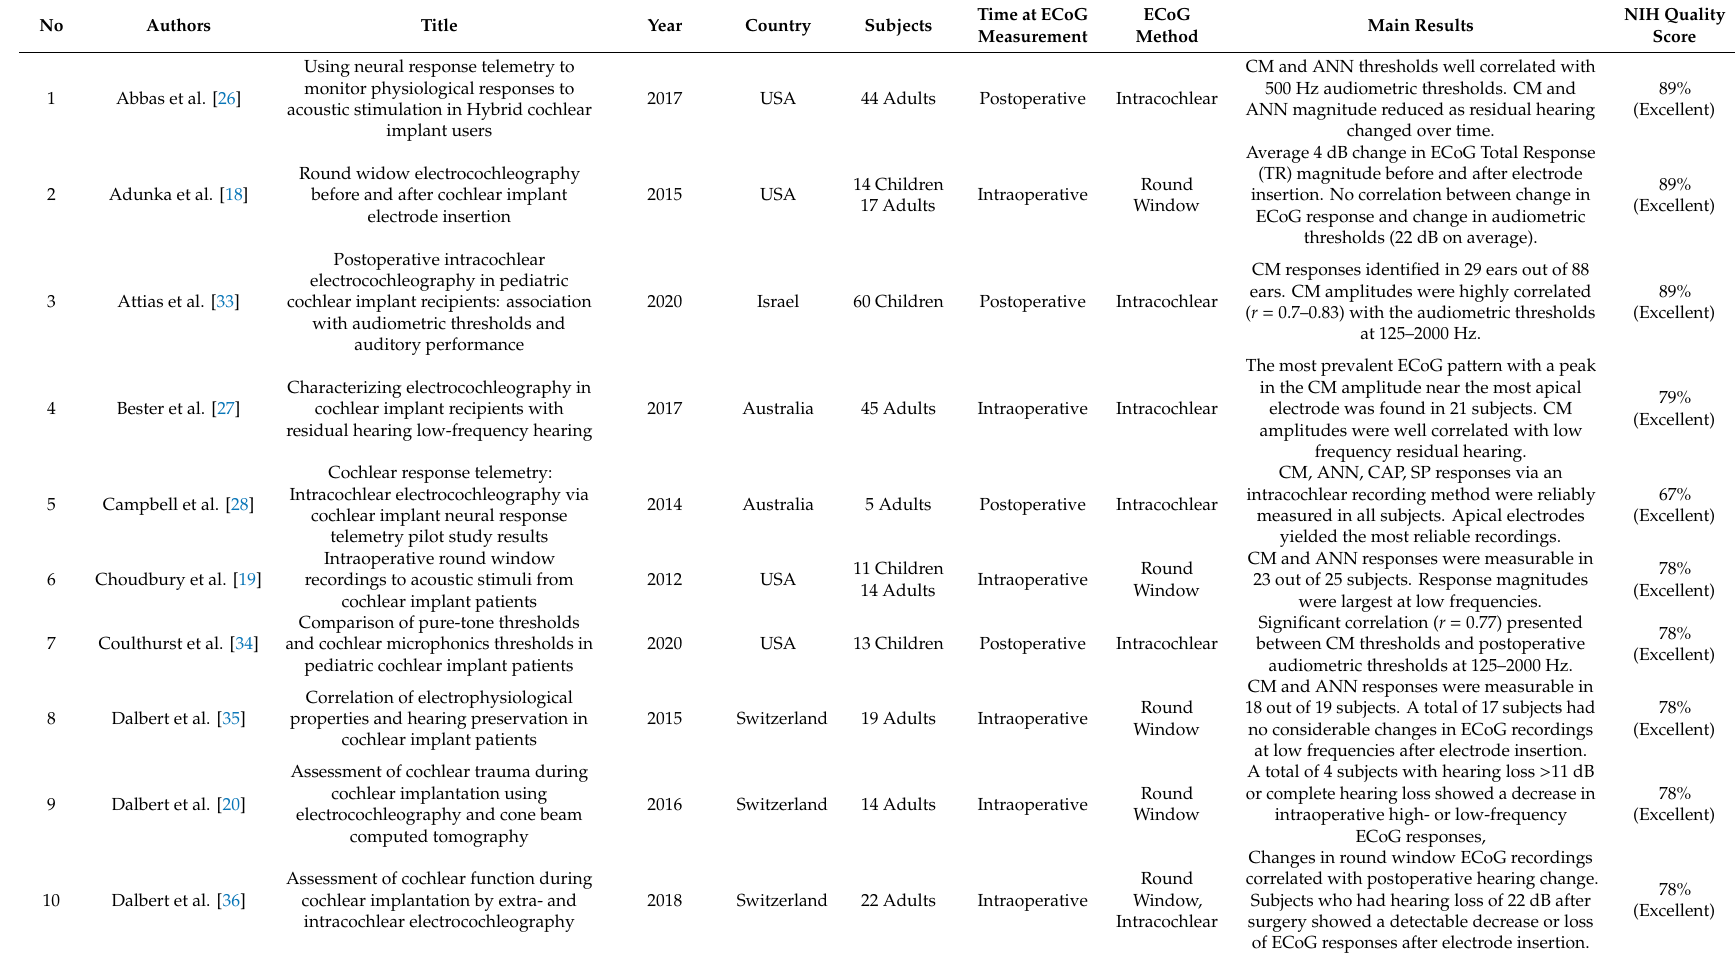
Table 1. Summary of 30 included